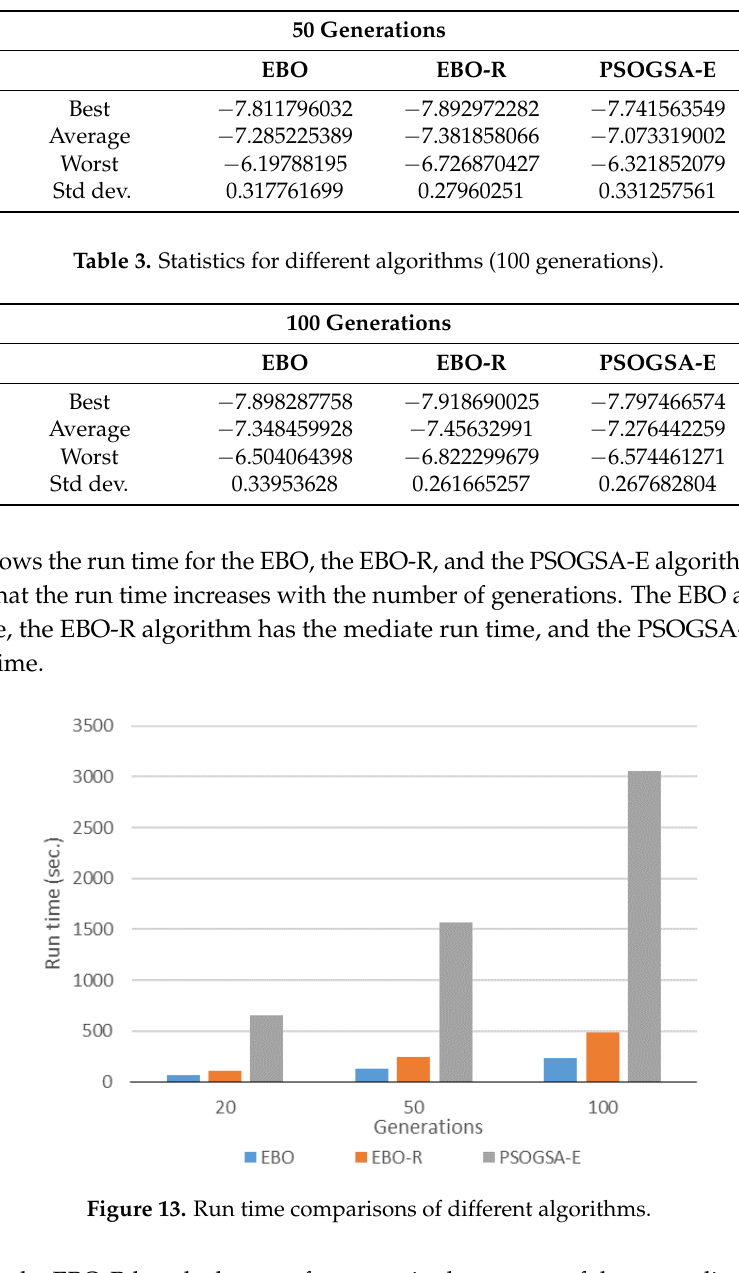
Table 1. Statistics for different algorithm (20 generations).